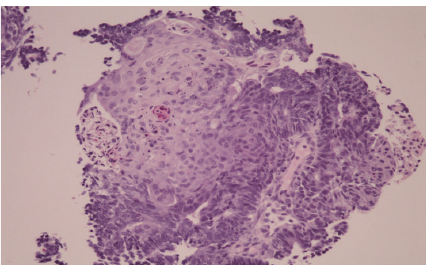
Figure 2: Original biopsy diagnostic of an epithelioid malignancy with variable differentiation patterns including solid areas with squamoid features and glandular areas. Diagnosis was of adenocar- cinoma with squamous differentiation with qualification to exclude a carcinoma of endometrial